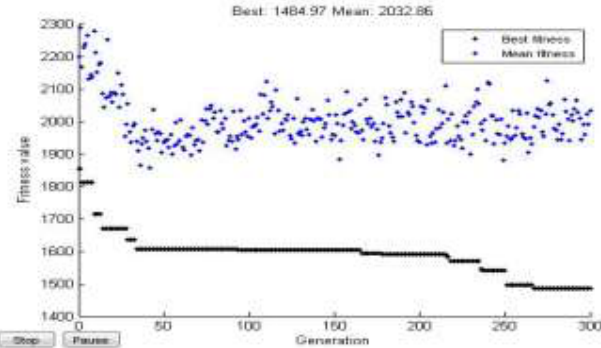
Figure 2. The development of genetic algorithms.